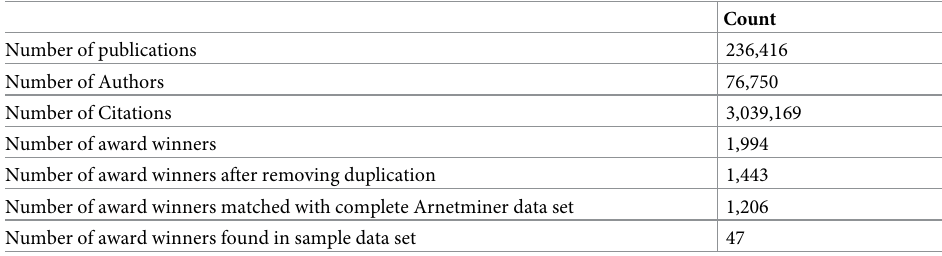
Table 1. Statistics of sample data